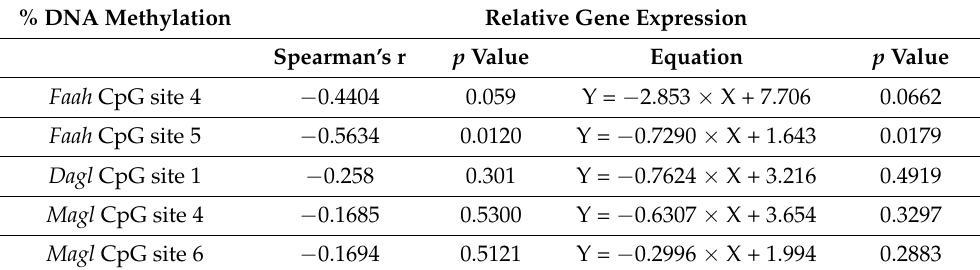
Table 2. Correlation analysis between the percentage of DNA methylation and gene expression in Faah , Dagl, and Magl observed in rat hypothalamus. Data were compared by Spearman’s rank correlation coefficient, and r and p values are reported. % DNA Methylation Relative Gene Expression Spearman’s r p Value Equation p Value Faah CpG site 4 − 0.4404 0.059 0.0662 Faah CpG site 5 − 0.5634 0.0120 Y = − 0.7290 × X + 1.643